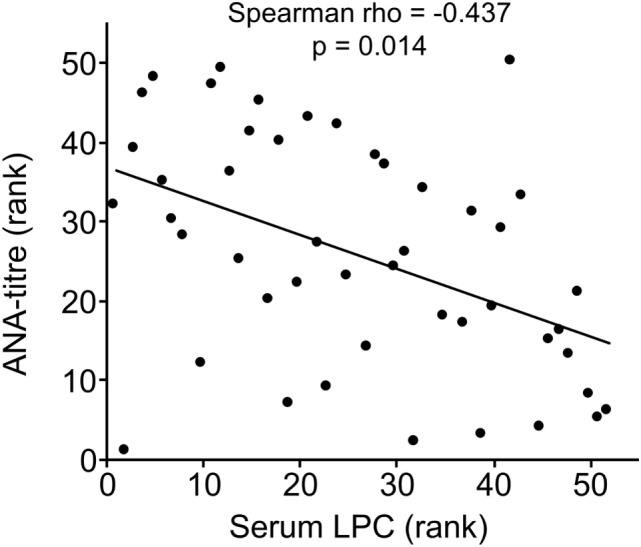
Lysophosphatidylcholine (LPC) serum levels of patients with systemic lupus erythematosus inversely correlated with antinuclear antibody (ANA) titers. Correlation analysis of serum LPC values and ANA titers. The values of ANA titers and serum LPC concentrations were transformed to rank values, and the Spearman rho correlation coefficient was calculated (p = 0.014 after Bonferroni correction).